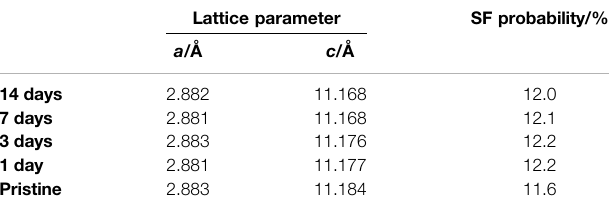
TABLE 1 | Lattice parameters and stacking fault probabilities derived from re fi nement of X-ray diffraction patterns of pristine and stored materials. Lattice parameter